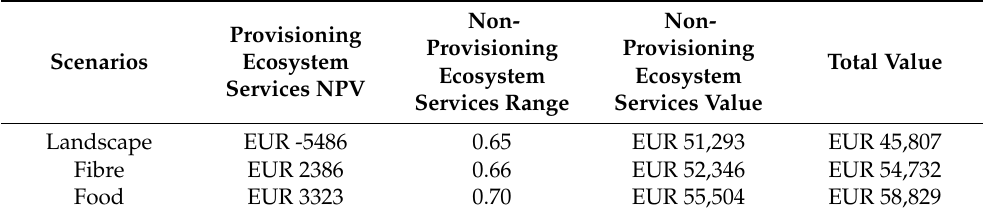
Table 6. The new total value of the considered scenarios per ha according to EU ETS Phase 4, including the welfare ecosystem service. Non- Non- Provisioning Provisioning Provisioning Total Value Scenarios Ecosystem Ecosystem Ecosystem Services NPV Services Value Services Range Landscape EUR -5486 0.65 EUR 51,293 EUR 45,807 Fibre EUR 2386 0.66 EUR 52,346 EUR 54,732 Food EUR 3323 0.70 EUR 55,504 EUR